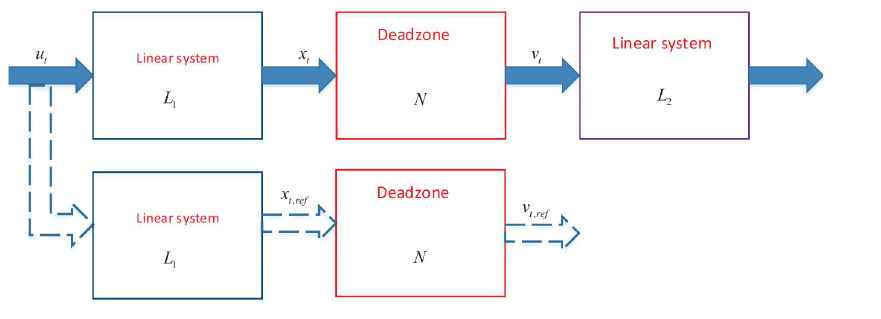
Fig 4. Auxiliary model